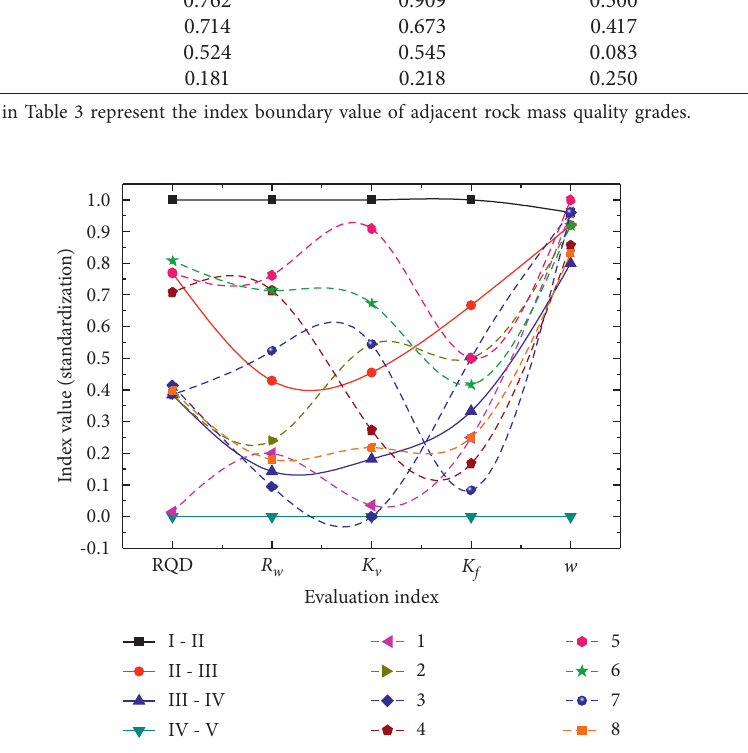
Figure 3: Analysis of grades of sample